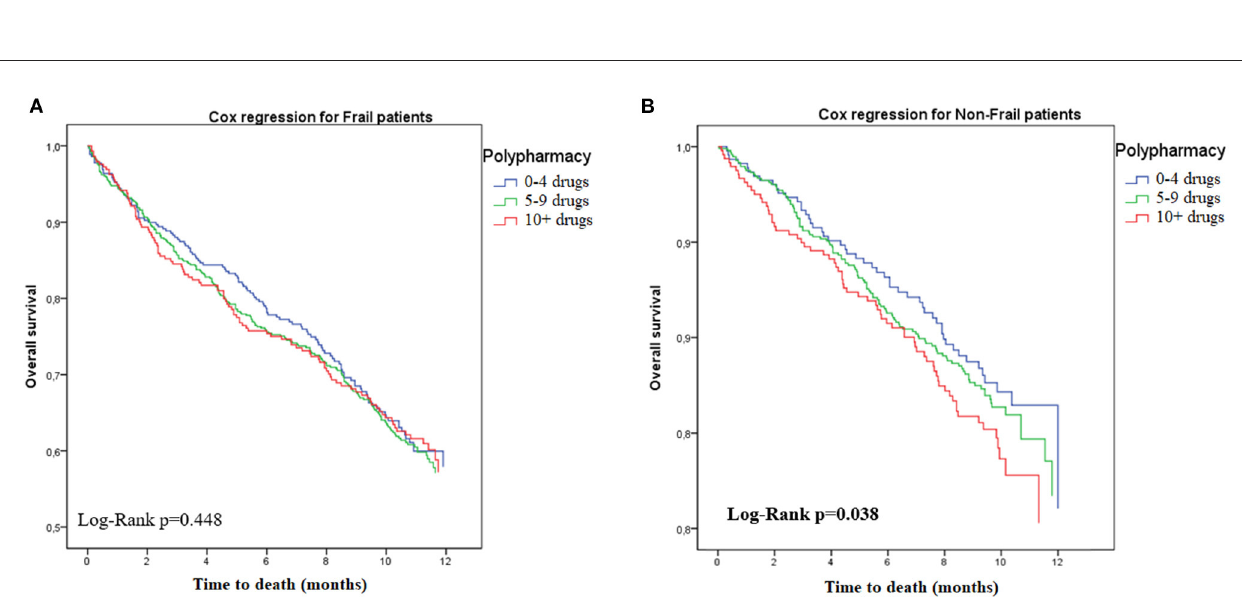
FIGURE2 Risk of death according to polypharmacy status, stratified by frailty. (A) Frail. (B)